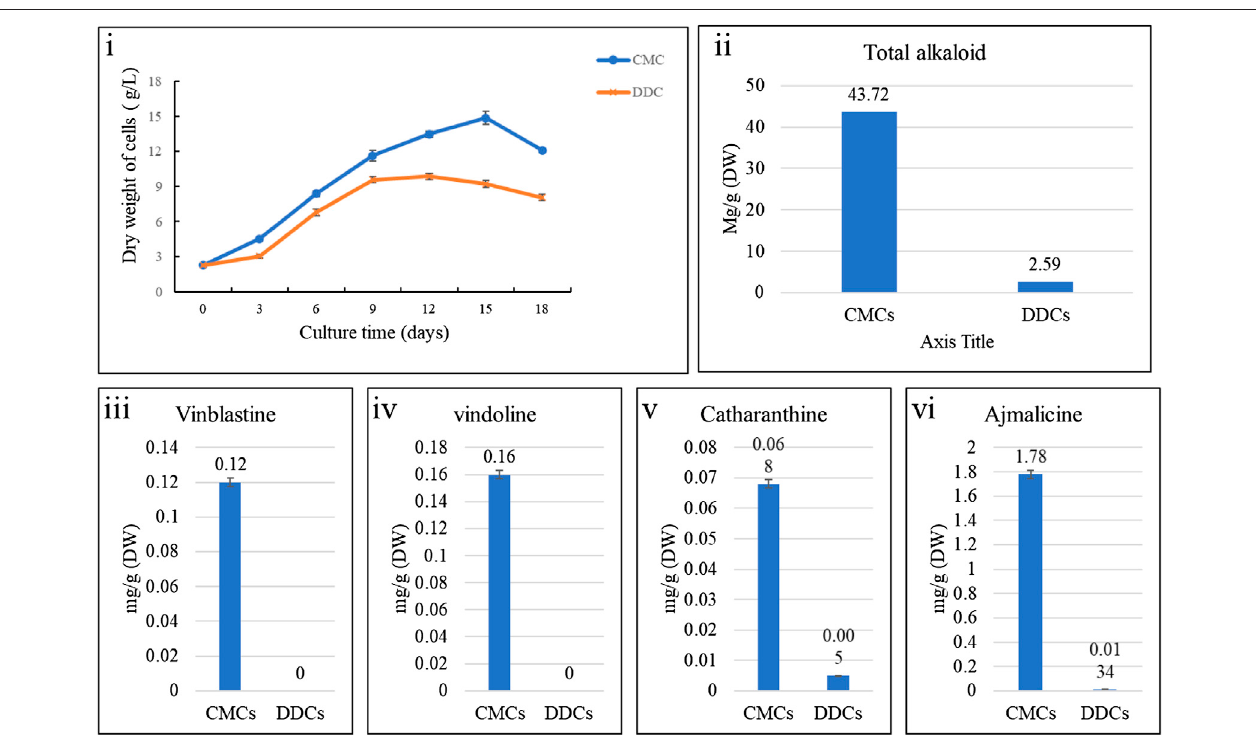
FIGURE 1 | Dry weight and alkaloid content of C. roseus cambial meristematic cells (CMCs) and dedifferentiated cells (DDCs). i) Changes in dry weight over time, comparison of mean content ofii) total alkaloids, iii) vinblastine, iv) vindoline, v) catharanthine, and vi) ajmalicine. The bars represent mean values for three replicates. The error bars represent standard deviation.